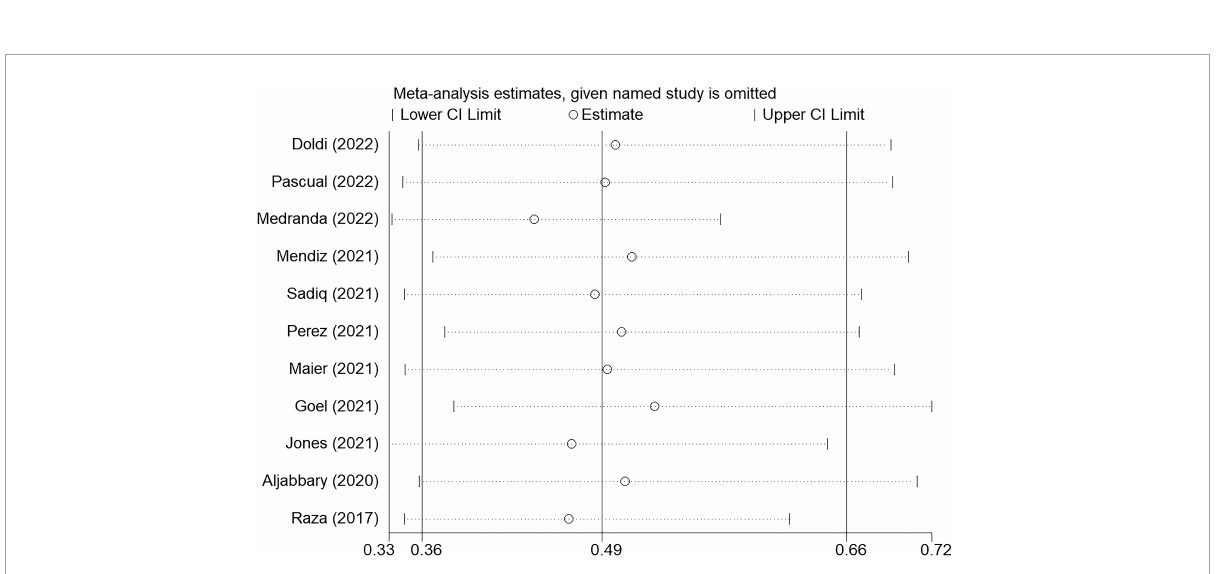
FIGURE8 Sensitive analysis through sequentially omitting each study from the pooled analysis. The effect size remained stable when any of the studies were omitted. The application of the COP technique was associated with approximately half PPI risk reduction in all models.